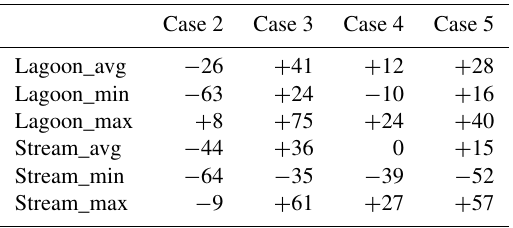
Table 3. Average, minimum, and maximum percentage changes in estimated vertical groundwater fluxes compared to using a standard thermal conductivity value of 1.84Wm − 1 ◦ C − 1 representative of sand and traditionally used in local